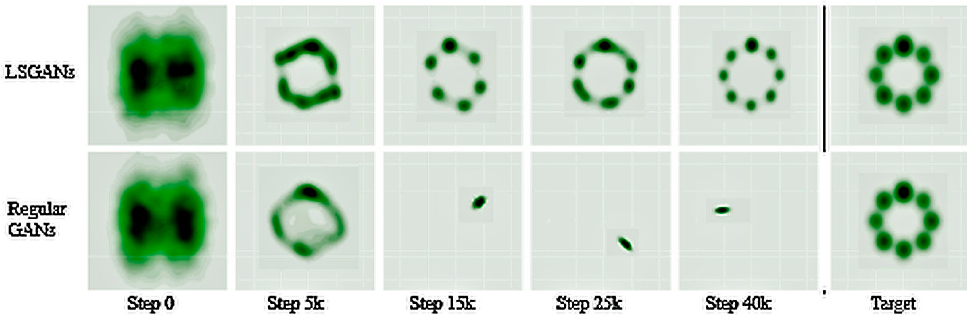
Figure 11. A comparison of vanilla GANs and LSGANs iterate through the dataset to produce the target output.